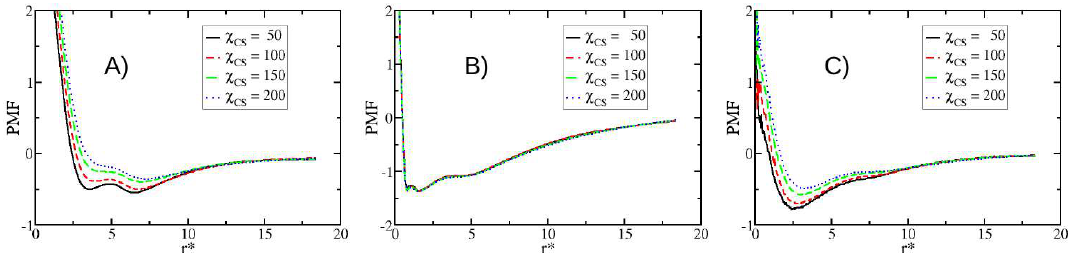
Figure 6. Potentials of mean force (PMF) for different concentration of CS, as function of separation distance between mass centers of each molecule. ( A ) Lecithin-CS; ( B ) lecithin-capsaicin; and ( C ) capsaicin-CS. All quantities are expressed in reduced DPD units.